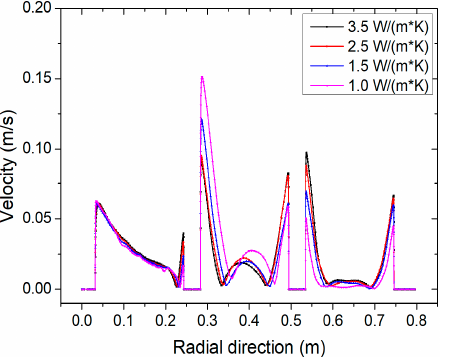
Figure 12. Radial distribution of velocity magnitude for different thermal conductivity of SiC.